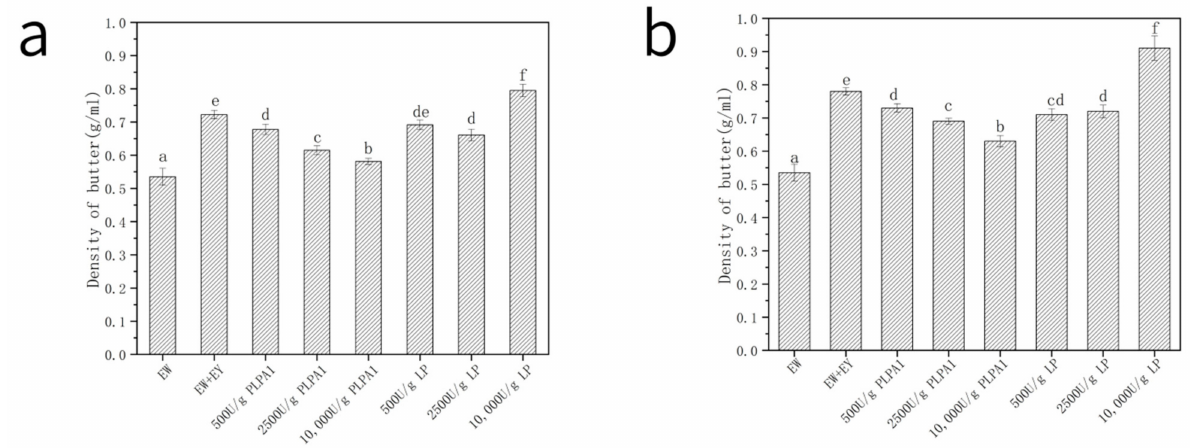
Figure 6. Batter densities contaminated by EY after hydrolysis. EW dispersion contaminated by 0.5 wt% ( a ) or 1 wt% ( b ) EY is hydrolyzed by PLPA1 or LP with different concentrations (500 U/g, 2500 U/g, 10,000 U/g). (Samples were prepared from and corresponded to the egg white solution in Table 2). Different letters for the same parameter indicate significant differences ( p < 0.05) between treatments in the two figures